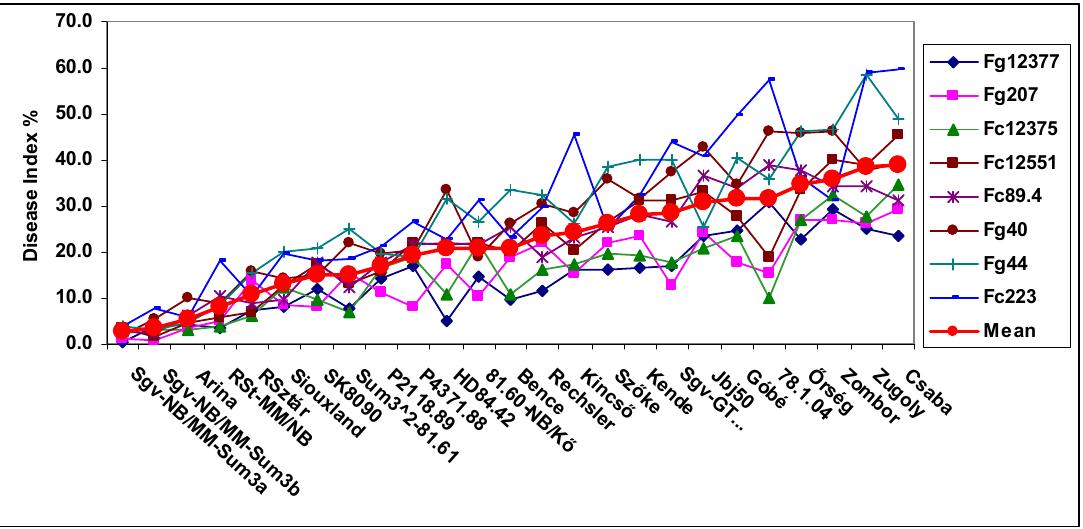
Figure 1. Resistance of winter wheat lines to F. graminearum and F. culmorum isolates 1994–1996. Disease index, [34]. Larger variations in surveying of the susceptible cultivars could suggest that the disease development is more variable in susceptible cultivars due to a mixture of factors including the genotypes. The most resistant ones have high stability and low variation.